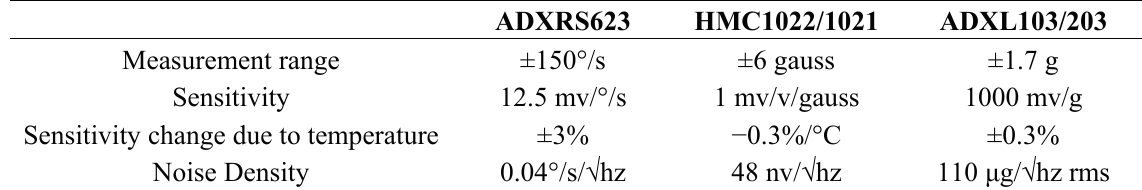
Table 1. The characteristics of